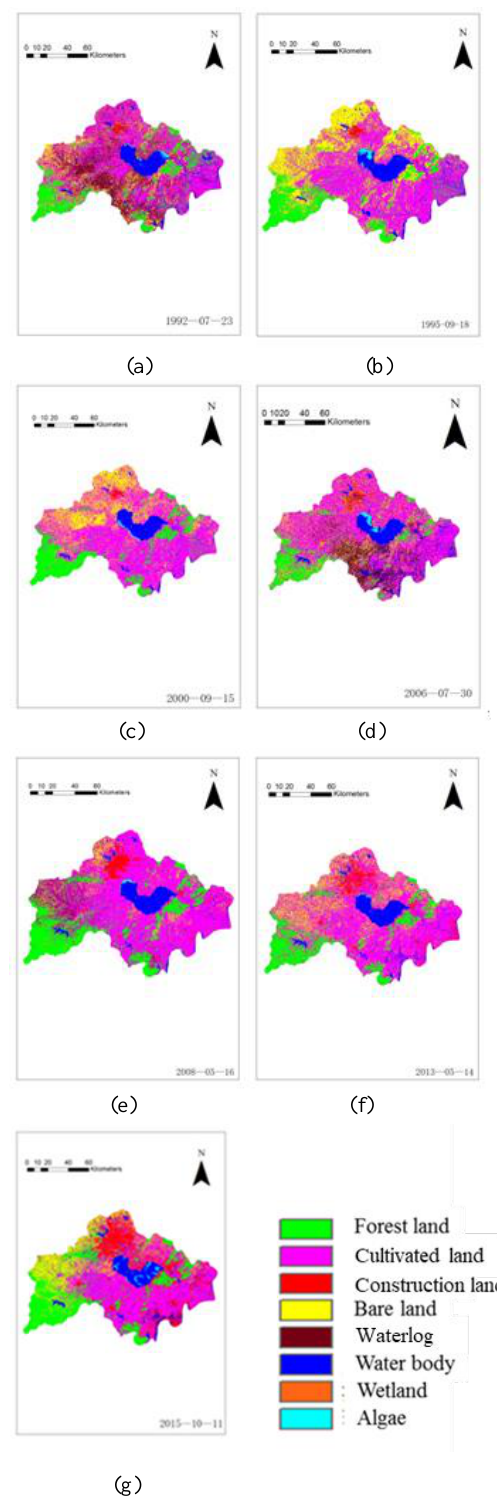
Figure 4. Classification results of the Chaohu lake